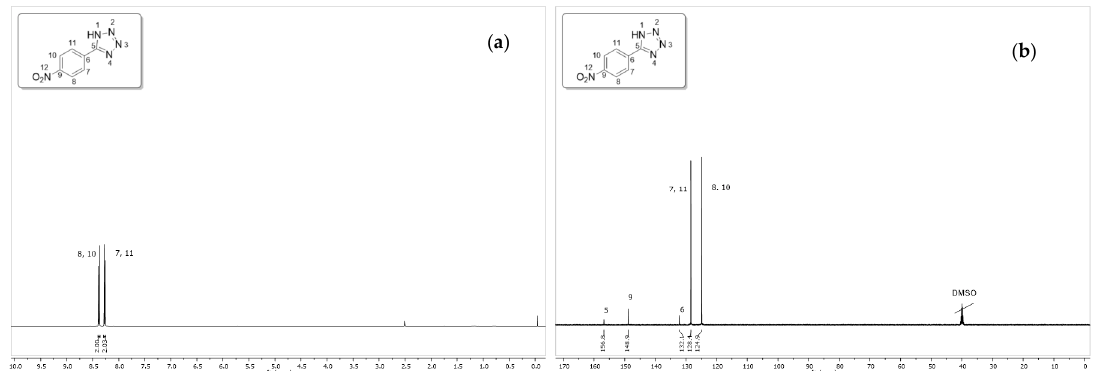
Figure 2. ( a ) 1 H NMR spectrum of the tetrazole 2 . ( b ) 13 C NMR spectrum of the tetrazole 2